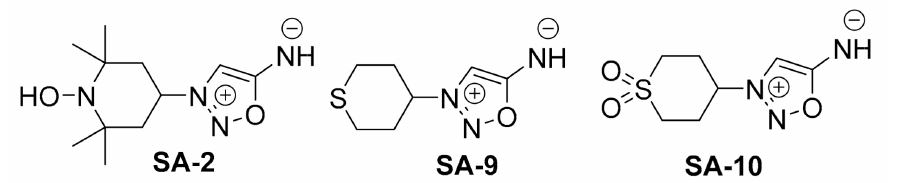
Figure 1. Chemical structures of the hybrid anti-oxidant, nitric oxide (NO)